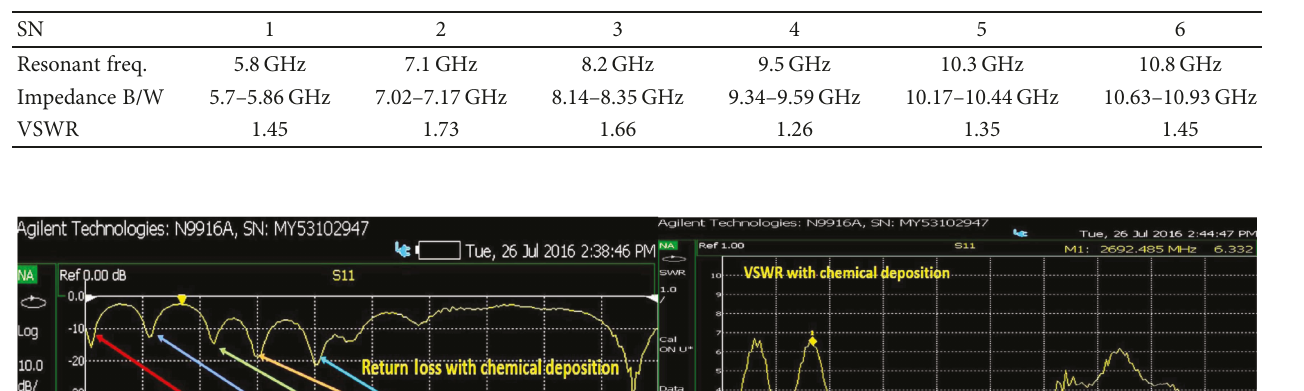
Table 2: Resonant frequency, impedance bandwidth, and VSWR bandwidth.